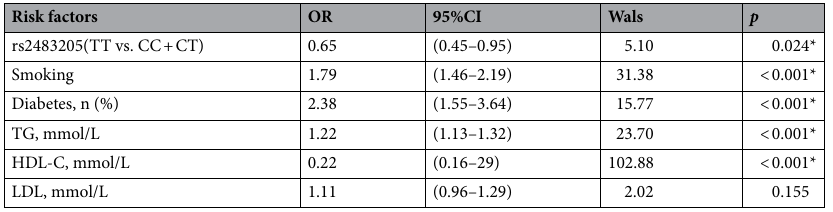
Table 3. Multiple logistic regression analysis for CAD patients and control subjects. Adjust: smoking, diabetes, TG, HDL-C, and LDL-C. TG triglyceride, LDL-C low density lipoprotein-cholesterol, HDL-C high density lipoprotein-cholesterol. * p -values <